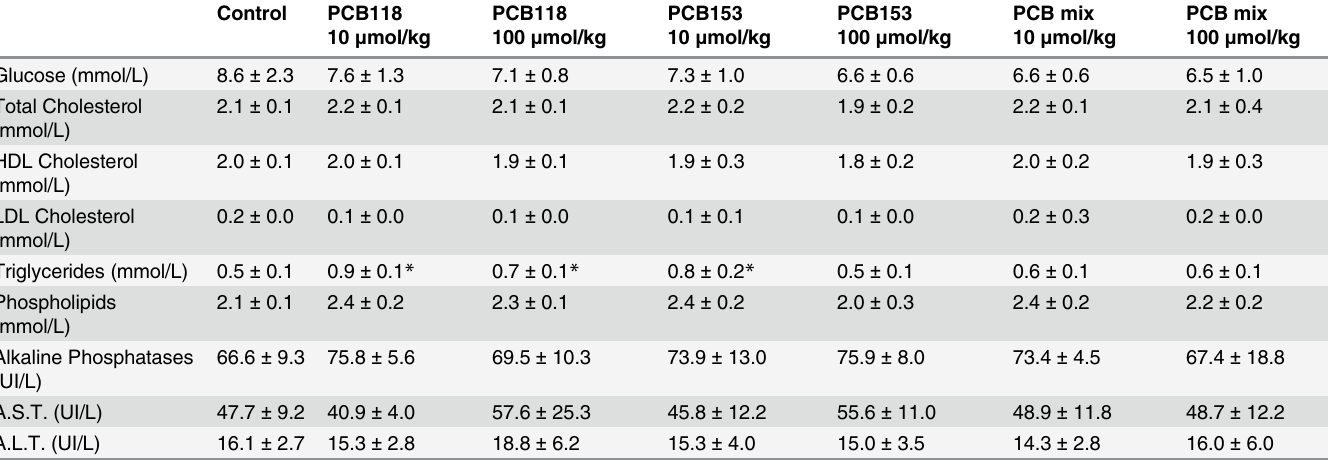
Table 3. Biochemical parameters from the different groups ( * p <